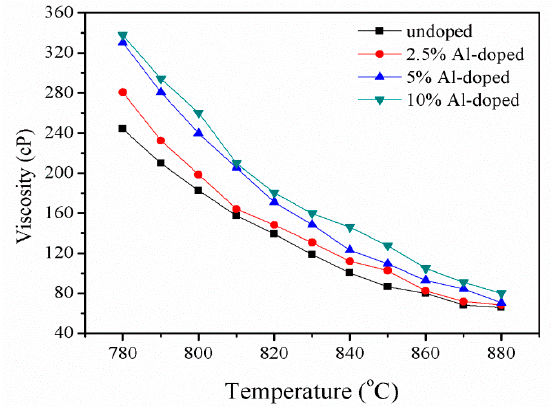
Figure 2. Viscosities of CLBO growth solutions with different Al doping concentrations.